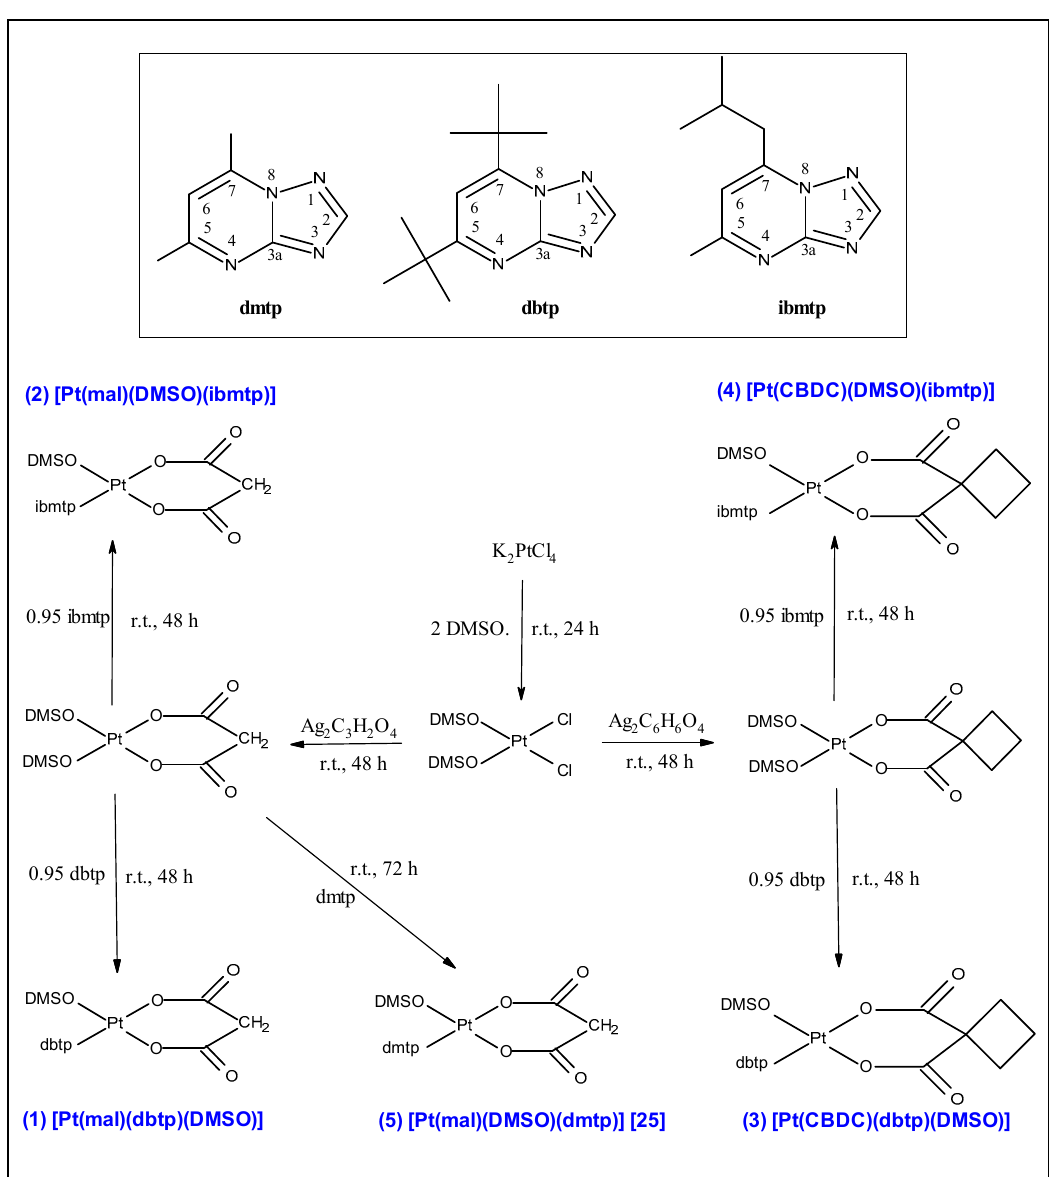
Figure 1. Synthesis pathways of platinum(II) complexes with 1,2,4-triazolo[1,5- a ]pyrimidines.